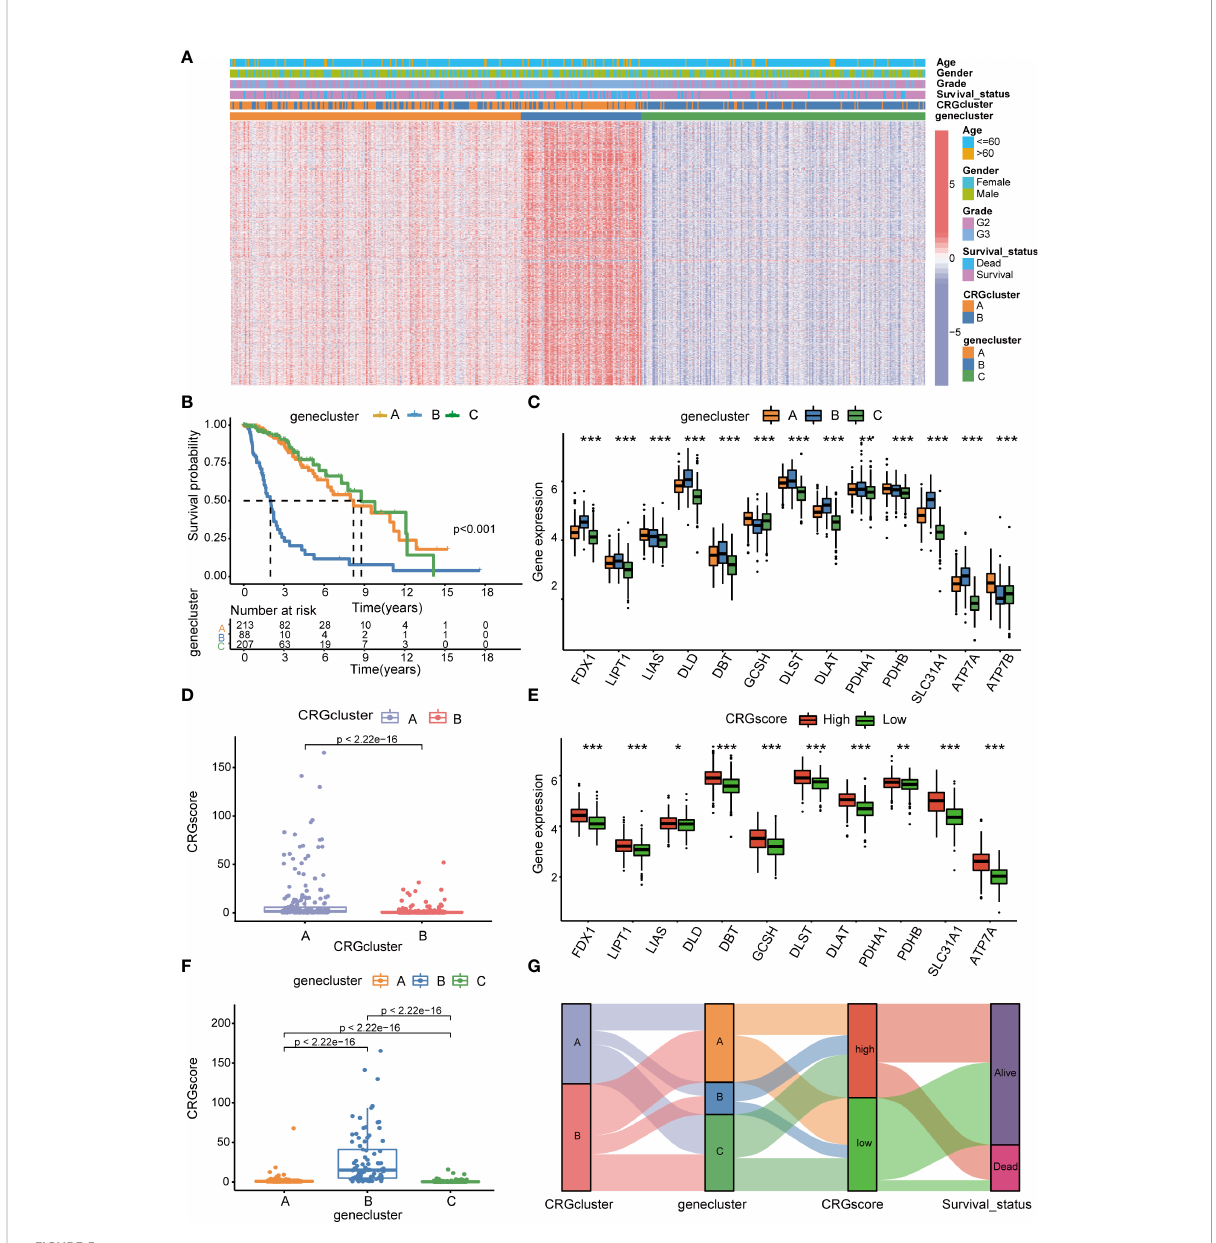
FIGURE 5 Identi fi cation of cuproptosis gene clusters and construction of the cuproptosis-related prognostic model in LGG. (A) The heatmap showed the different expressions of overall survival (OS) – DEGs and clinicopathological characteristics among gene cluster A to C (B) Kaplan – Meier OS curves for patients in the three gene clusters (log-rank test). (C) Differences in the expression levels of 13 CRGs among gene cluster A to C. (D) Differences in CRG scores between CRG cluster A and B (E) Differences in the expression levels of 13 CRGs between high- and low-risk groups. (F) Differences in CRG scores among gene cluster A to C, (G) Sankey diagram of subtype distributions in groups with different CRG scores and survival outcomes. P -values were shown as: * P <0.05; ** P <0.01; *** P <0.001. LGG, lower-grade glioma (WHO II and III); OS, overall survival; DEGs, differentially expressed genes; CRGs, cuproptosis-related